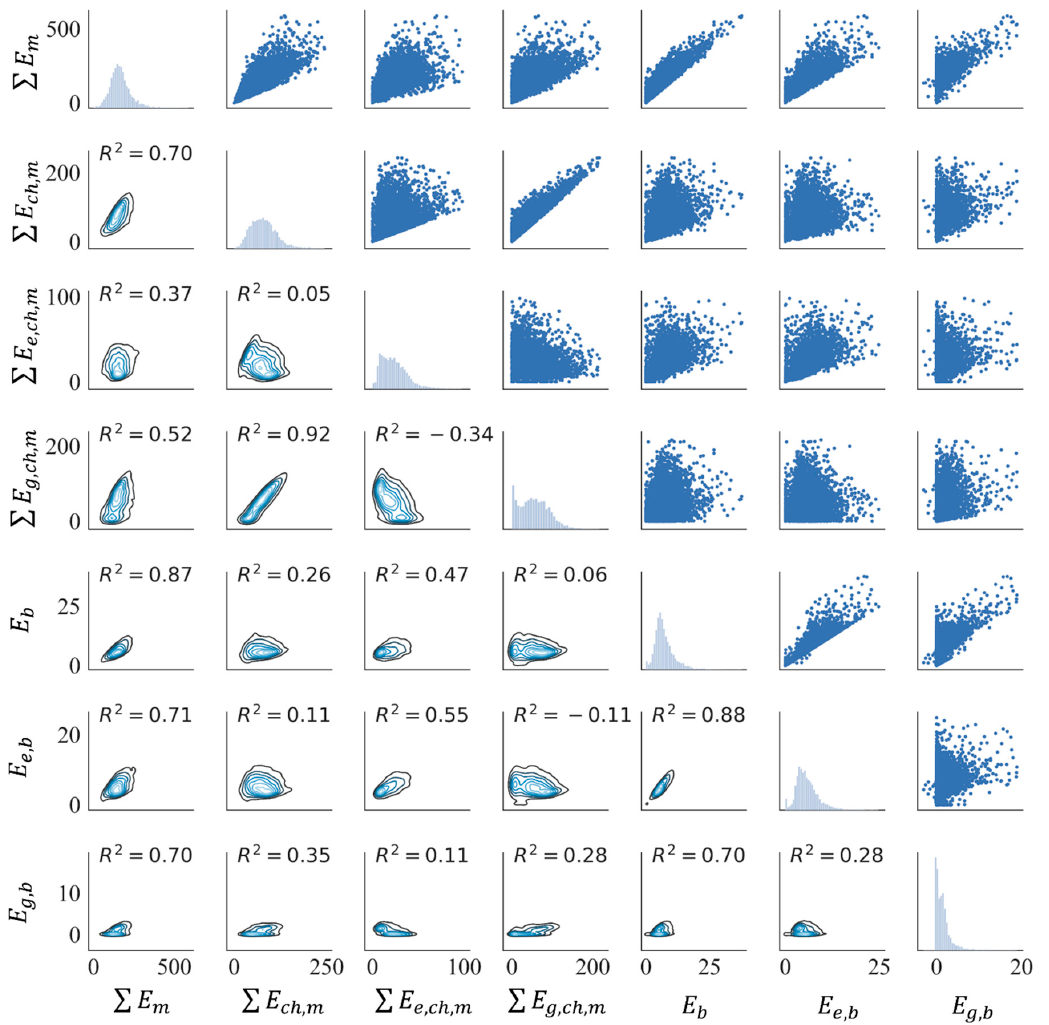
Figure 10. Correlations between the annual sum of total monthly energy, annual sum of monthly cooling and heating energy, and base energy (unit: kWh/m 2 · year) shown as Gaussian kernel densities, histograms, and scatter plots. (Python library seaborn was used).